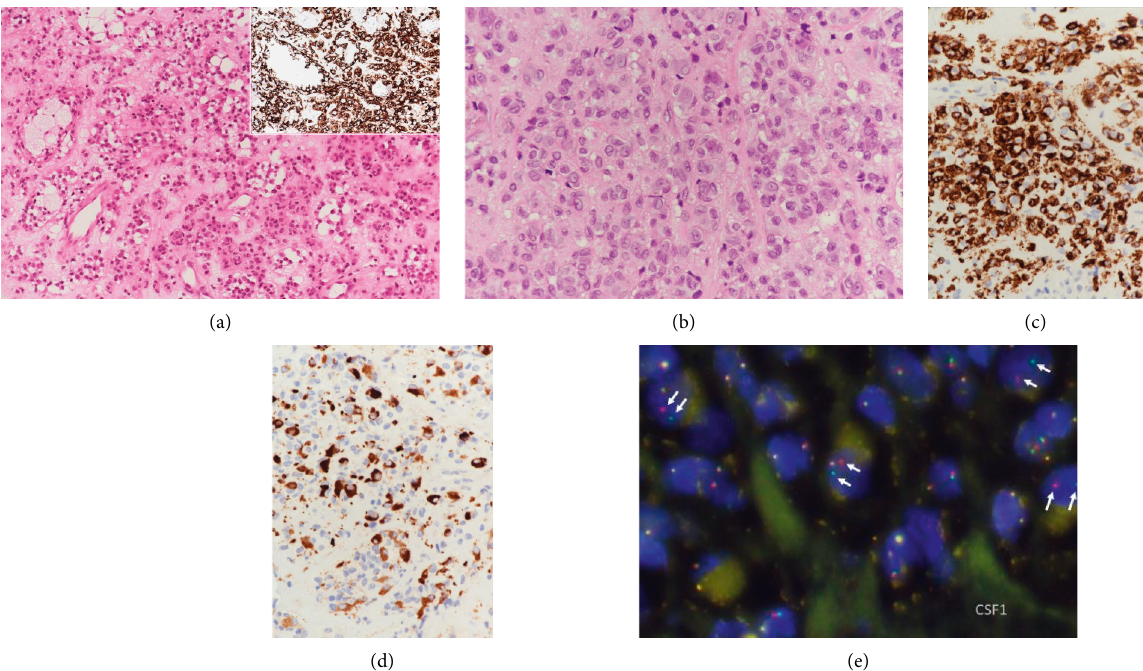
Figure 2: (a) Needle biopsy of cuboid lesion showed clusters and cords of pinkish epithelioid cells in a fibromyxoid stroma (H&E x40). The insert showed numerous CD1a-positive cells on immunohistochemistry (IHC x40). (b) The curettage specimen showed cellular clusters of pinkish epithelioid cells with open nuclei (H&E x400). (c) Majority of epithelioid cells are Langerin-positive Langerhans cells (IHC x400). (d) Scattered cells are Clusterin-positive tumour cells (IHC x400). (e) FISH showed scattered nuclei with break-apart green and red signals of CSF-1